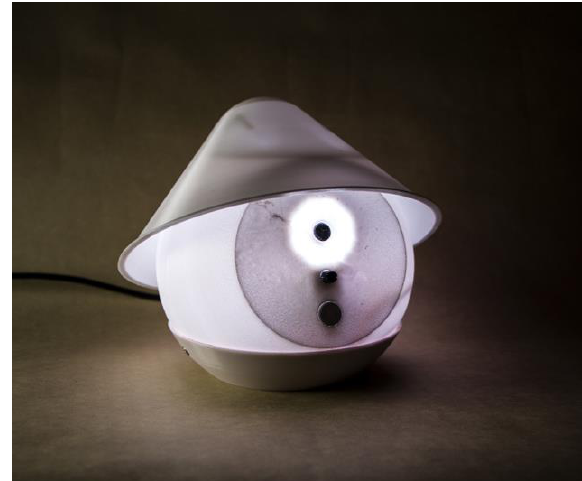
Figure 11 | Shybo robot: a high-fidelity and semi-functioning